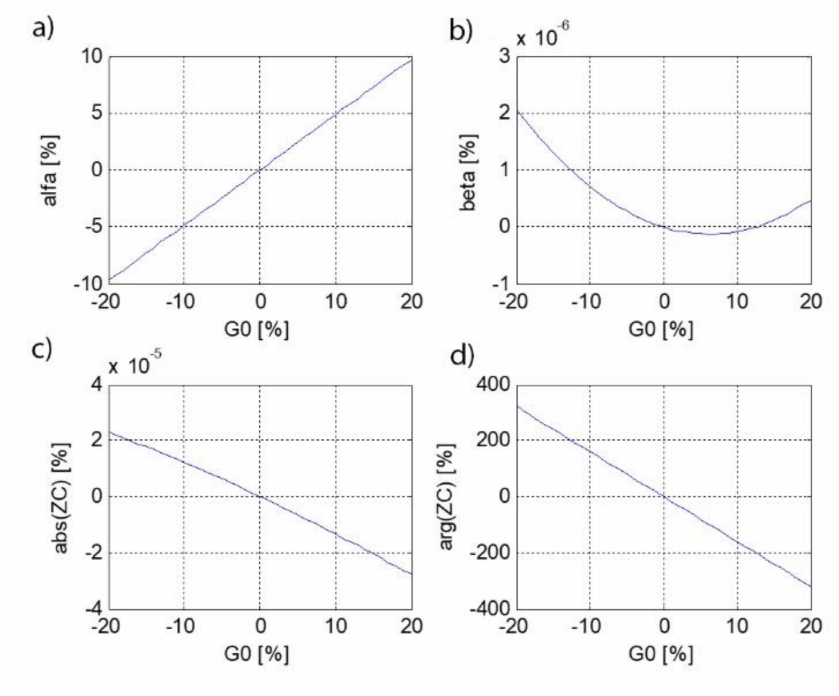
Figure 12. Changes of wave parameters depending on G 0 at f = 500 kHz; ( a ) damping factor α , ( b ) phase factor β , ( c ) wave impedance modulus, and ( d ) wave impedance